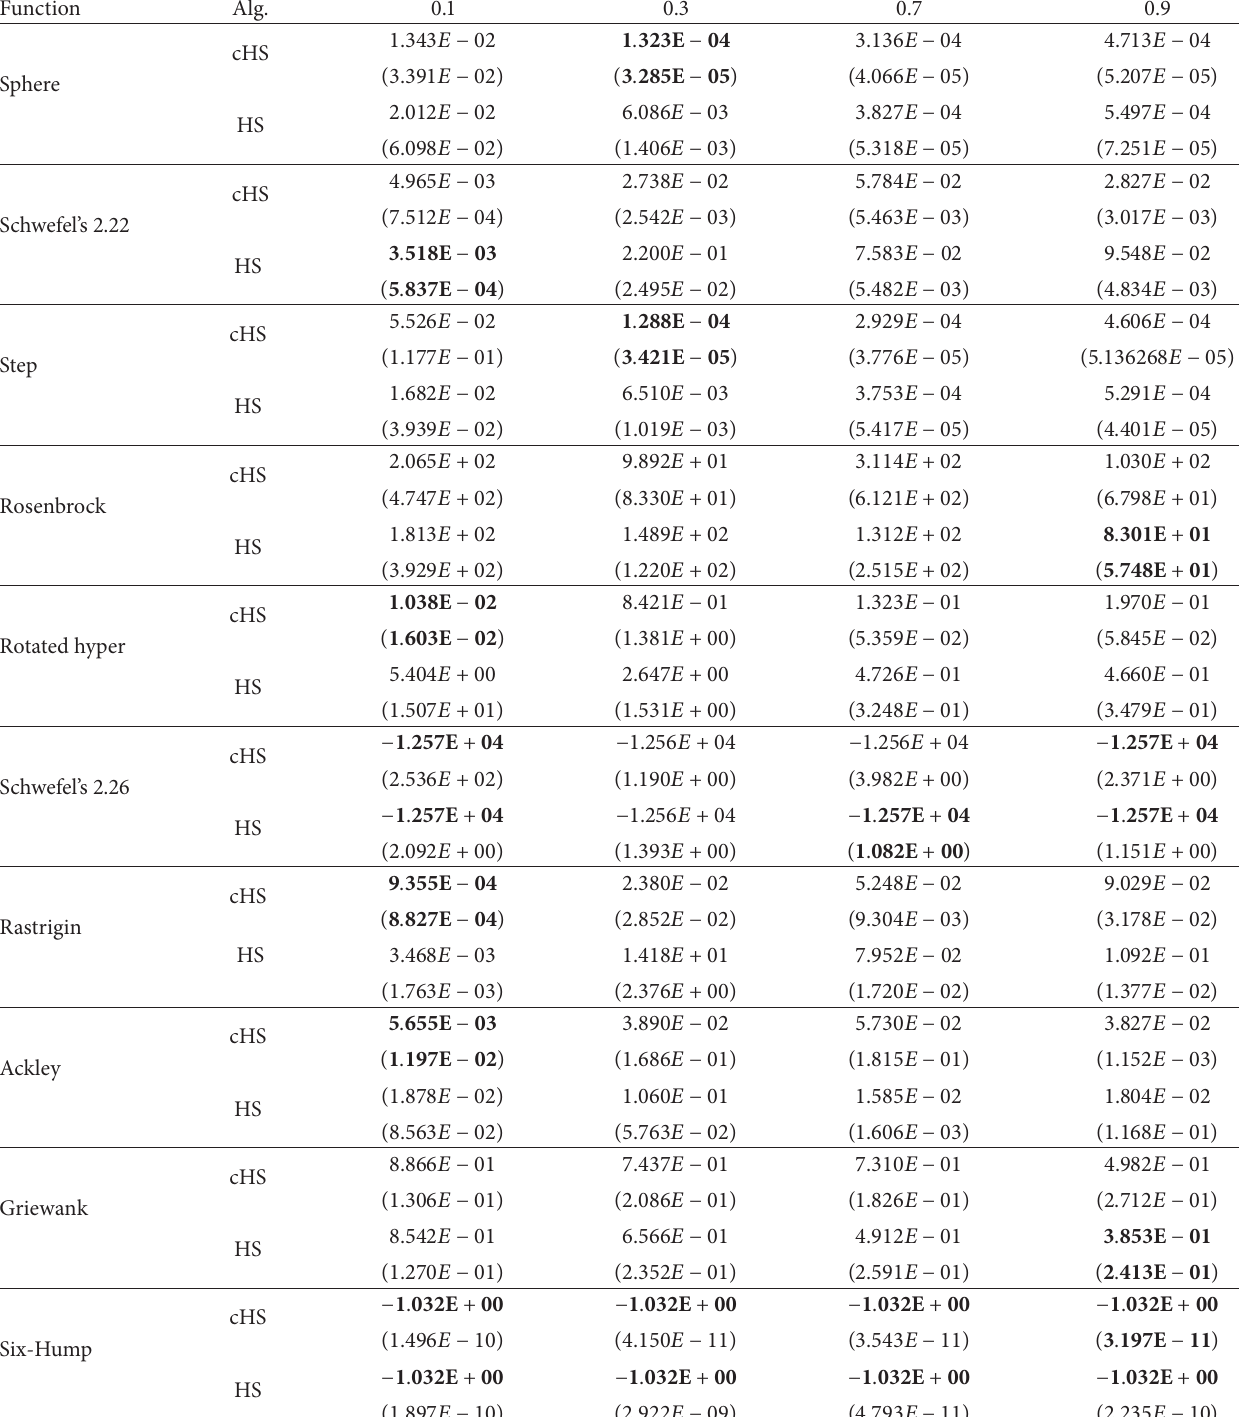
Table 6: The effect of varying the PAR parameter on HS and cHS for ten functions ( 𝑓 1 – 𝑓 10 ).